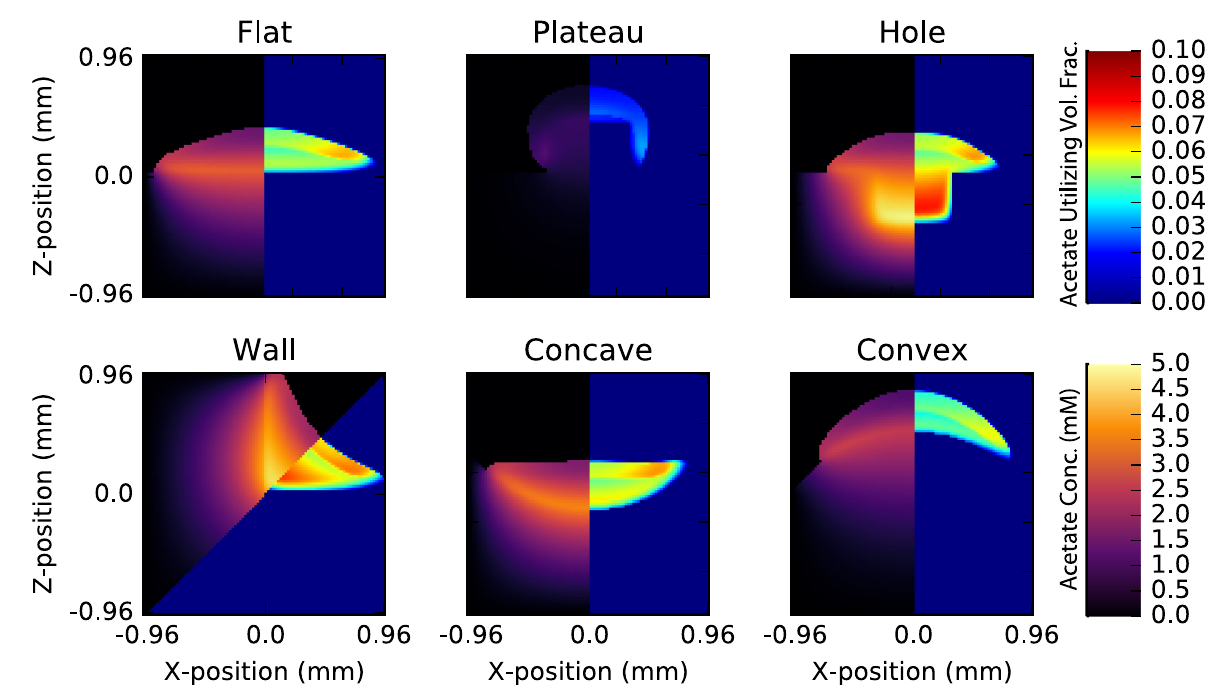
Fig 6. Geometry dependence of crossfeeding. Snapshotsof each of coloniesafter 35 hours of growth in six different geometries showingthe drastic difference in growth rate and acetate cross-feeding caused by agar geometry. Each image shows acetate concentration (left) and volume fraction of acetate utilizingcells (right). The acetate utilizingfraction are cells that have transitioned into the phenotypic state where they can catabolizeacetate; whilethese cellsaarenot necessarily consumping acetate, they have the capacity to do so. In general,about between45 and 76% of these cells are consumingacetate and are doing so at the maximum uptake rate.